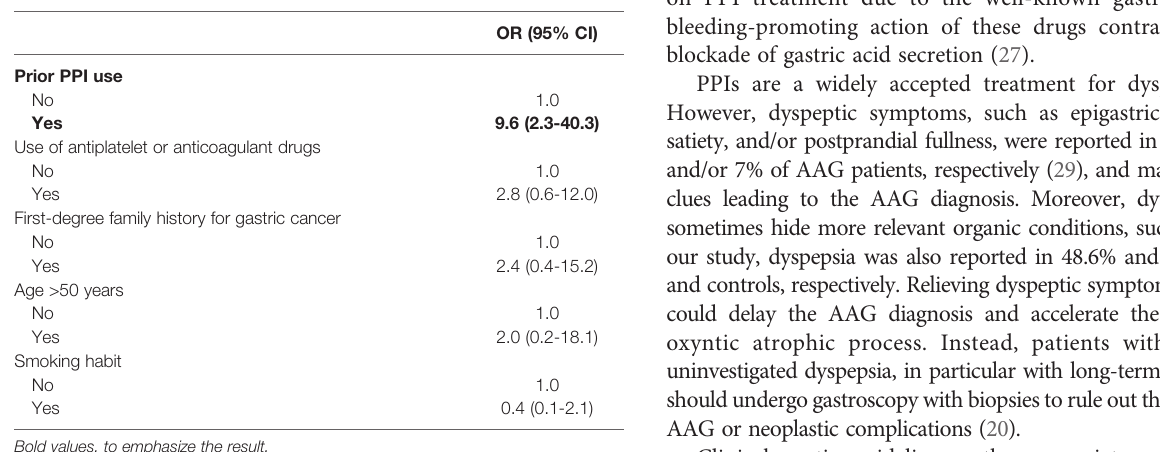
TABLE 3 | Features associated with the development of gastric neoplastic lesions in autoimmune atrophic gastritis (logistic regression).